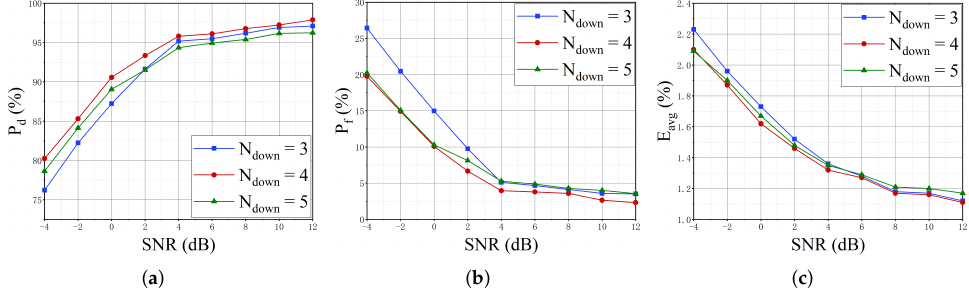
Figure 10. Performance variations with different numbers of downsampling layers. ( a ) detection probability; ( b ) false alarm probability; ( c ) mean absolute error of parameter estimation.